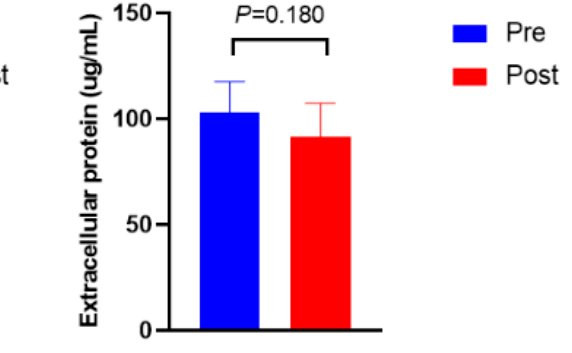
Figure 3. Microbial density, biofilm formation, and its related gene expression before (Pre) and after (Post) diet shift.